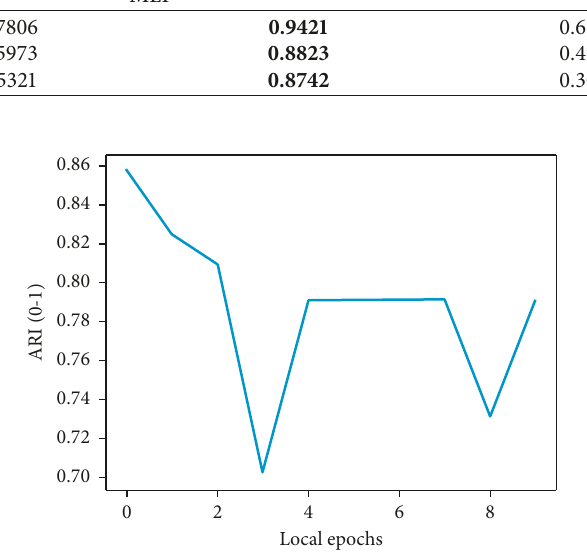
Figure 6: ARI results (Data sets � Cifar-10, min_sample � 2, xi �